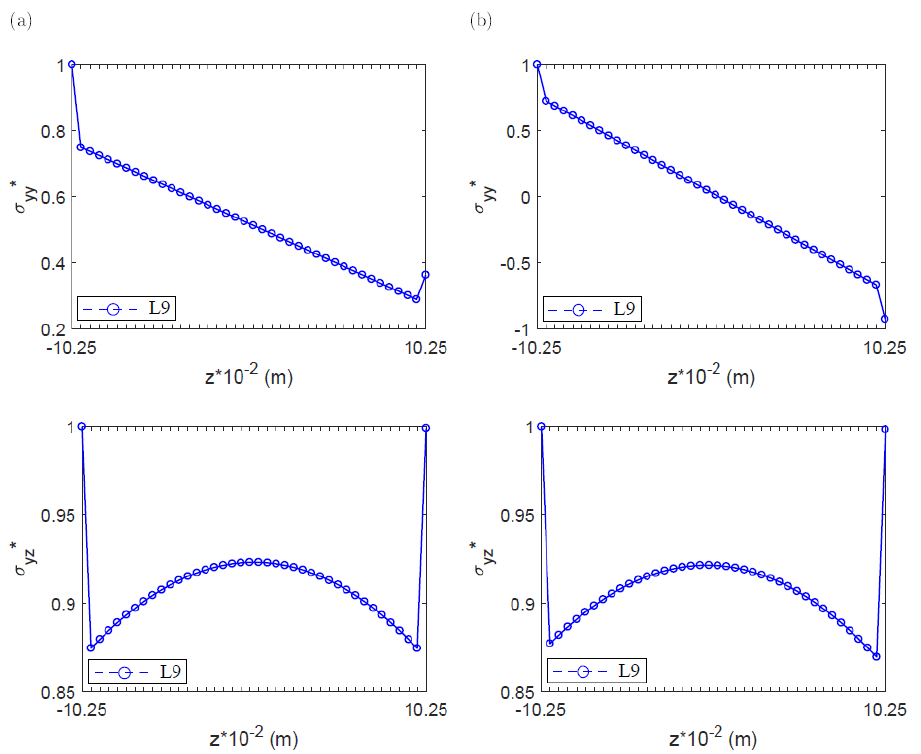
Figure 22. Distribution of axial and shear stress components for ( a ) P ∗ = − 0.0804 and ( b ) P ∗ = − 0.1446 loads in NL regime at L4 and L9 extensions at x = − a 2 /2 and y = L /2 in the two-cell FG beam subject to axial loading; σ ∗ yy = σ yy / σ yy